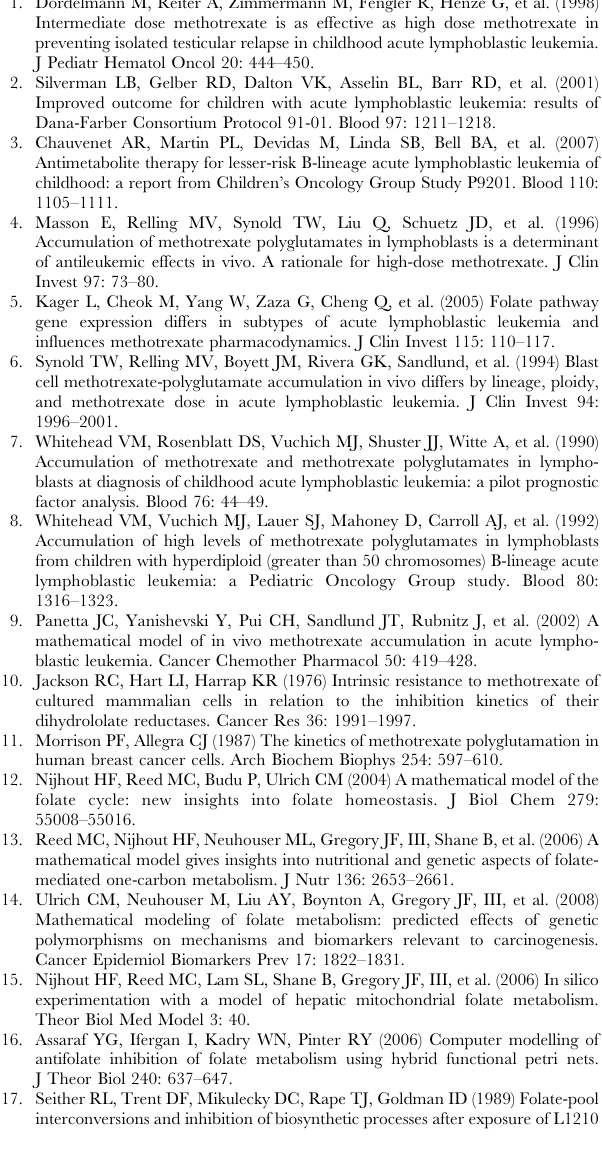
IIV: Inter-individual variability; CV: coefficient of variation.